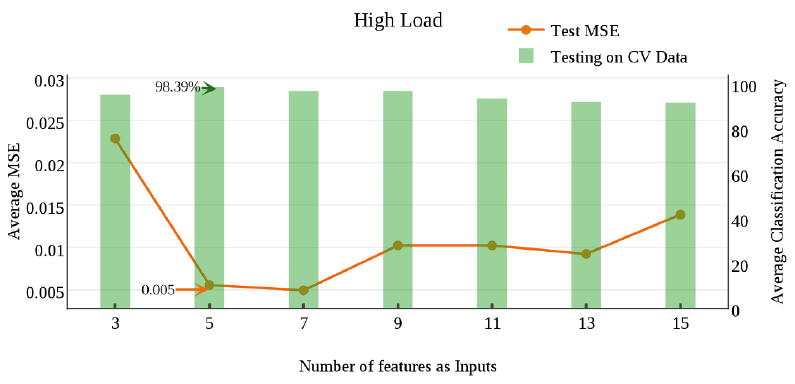
Figure 9. Variation of average classification and mean squared error (MSE) with a number of features as inputs in High Load.